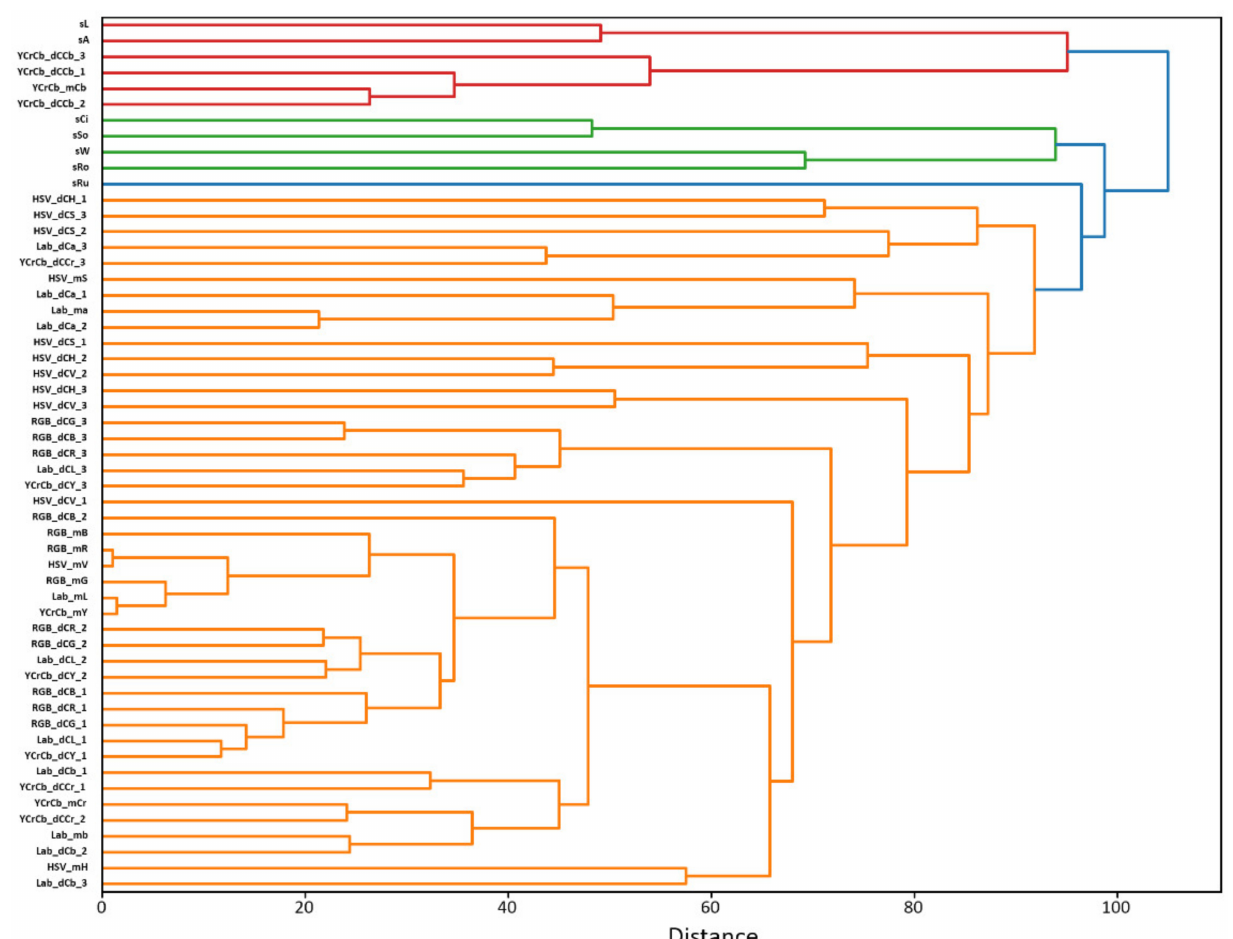
Figure 1. Clustering of wheat grain traits based on the analysis of 44 RILs from ITMI population. Four clusters of traits are highlighted with different colors: large cluster of color traits (orange), seed shape traits (green), traits of seed size and Cb component of the YCrCb color space (red), rugosity